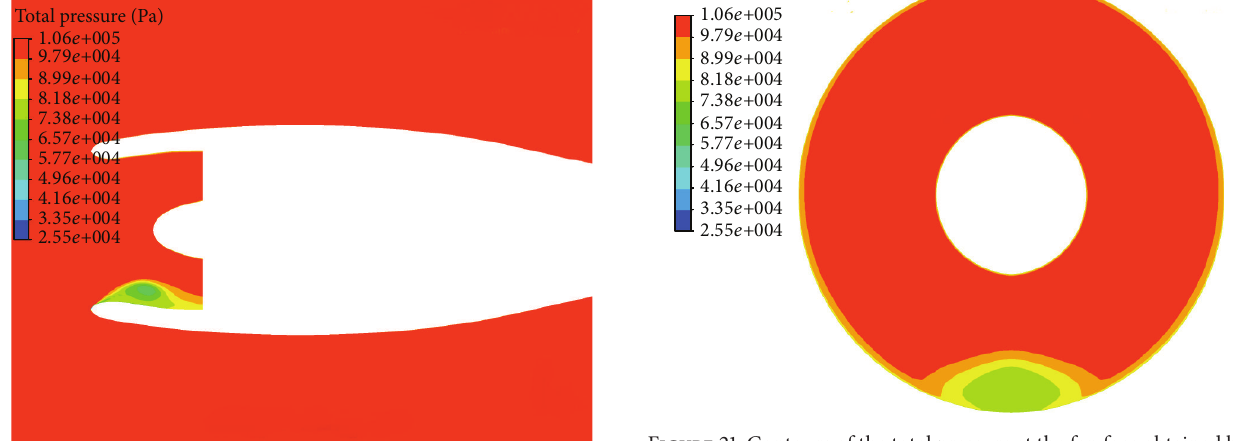
Figure 21: Contours of the total pressure at the fan face obtained by the AD at the last